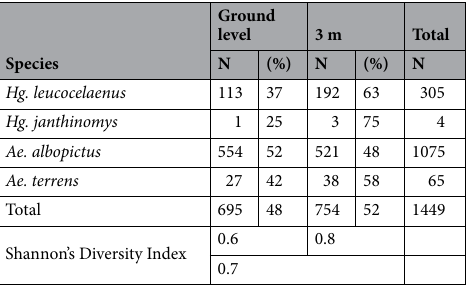
Table 1. Relative abundance, Shannon index and total number of culicids collected in Córrego da Luz, Casimiro de Abreu, Rio de Janeiro, Brazil, from July 2018 to December